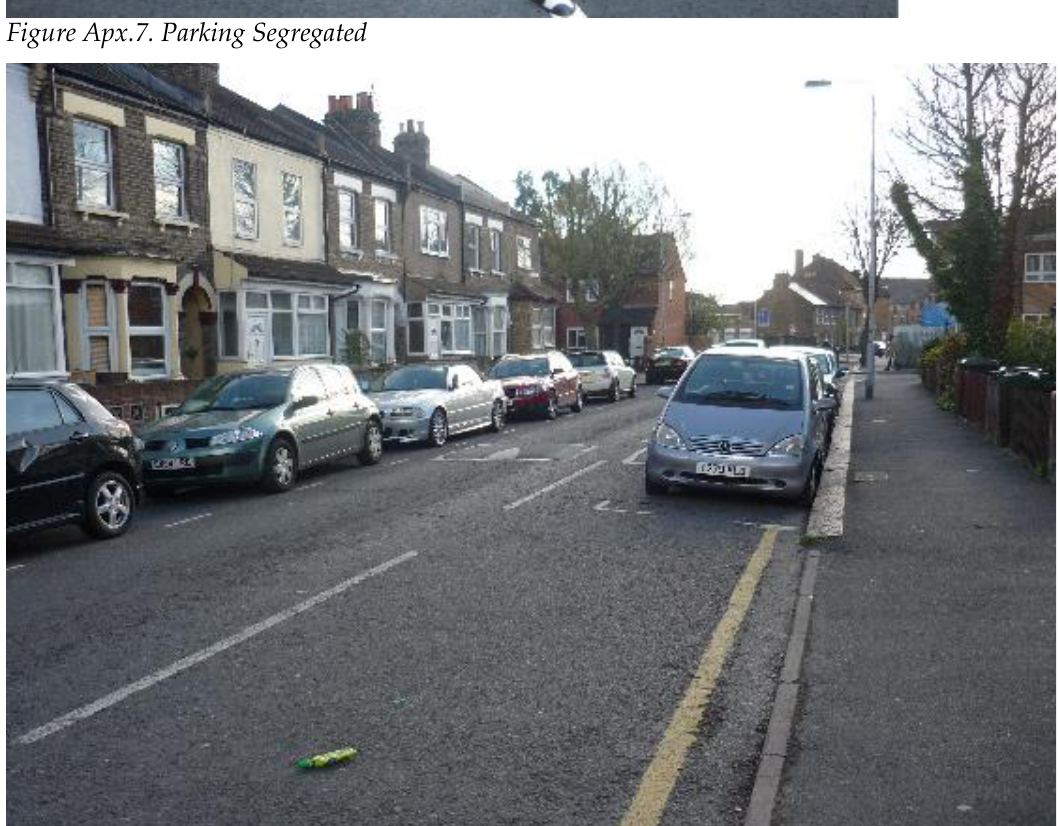
Figure Apx.7. Parking Segregated